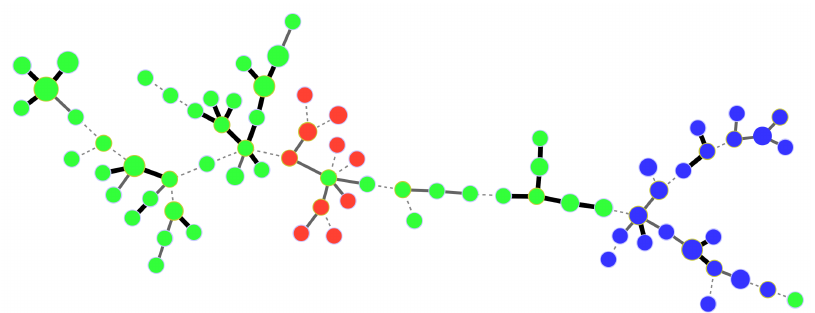
Figure 3. Categorical minimum spanning tree from MLVA-14 data showing the genetic relatedness among strains of Xanthomonas citri pv. citri in the Comoros. Dots represent haplotypes. Dot diameter and colour are representative of the number of strains per haplotype and island of isolation, respectively (red = Anjouan; blue = Grande Comore; green = Mayotte). Single, double and triple locus variations are represented as thick solid, thin solid and dotted lines joining haplotypes,